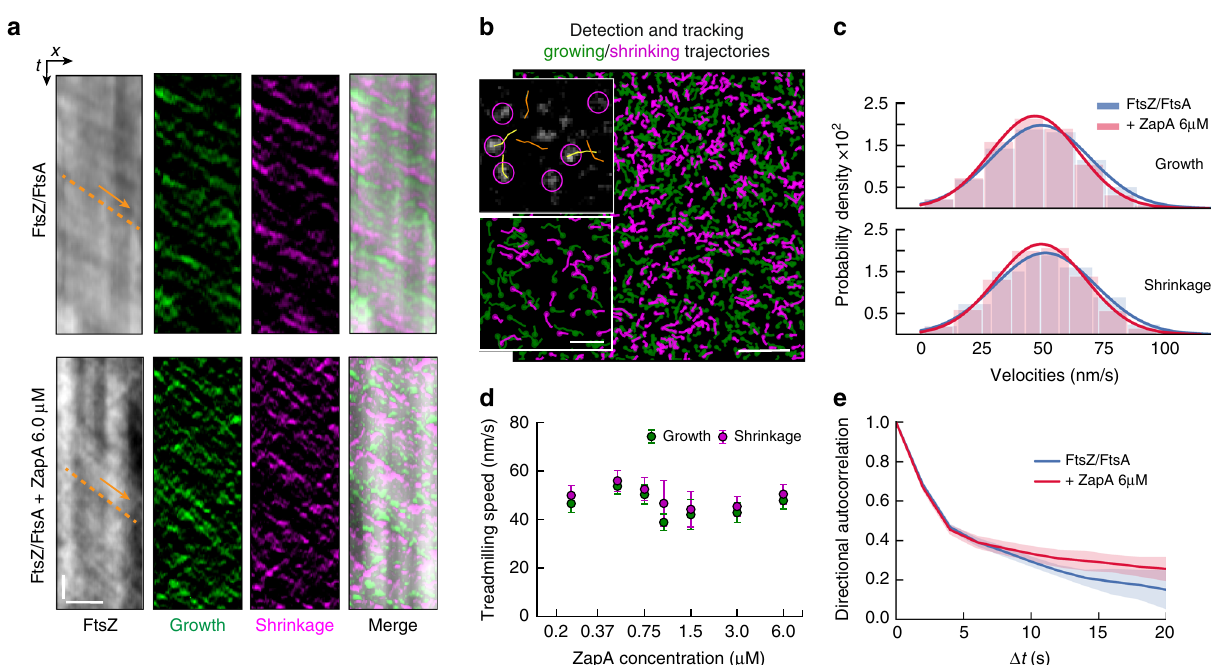
Fig. 5 ZapA does not change treadmilling speed of FtsZ fi laments. a Kymographs obtained along the orange line in Fig. 4b. Images represent the channel with the raw data, the two differential channels (growth and shrinkage trajectories) and the merged image. Arrows indicate treadmilling direction. Scale bars, t = 20 s, x = 3 μ m. b Snapshot showing an example of detection (purple circles) and tracking (yellow/orange lines) of fl uorescent spots and the respective generated growing and shrinking trajectories, respectively. First position of each trajectory is indicated with circles. Scale bars: large image, 5 μ m; small image, 2 μ m. c Velocity distribution of fi lament growth (upper panel, FtsZ/FtsA, ν + = 50.5 ± 20.1 nm/s, FtsZ/FtsA + ZapA, ν + = 47.8 ± 18.2 nm/s, n = 10) and shrinkage (lower panel, FtsZ/FtsA, ν − = 53.0 ± 20.7 nm/s, FtsZ/FtsA + ZapA, ν − = 50.4 ± 18.6 nm/s, n = 10). Both show a normal distribution without any signi fi cant difference in the mean. d Increasing concentrations of ZapA had no effect on the mean velocity of FtsZ fi laments at either end ( p > 0.05; Supplementary Table 1). e Directional autocorrelation revealed that directionality was increased in the presence of 6 μ M ZapA (red) when compared to FtsZ/FtsA (blue). Data shows the average autocorrelation curve from individual experiments (shaded bars = std, n = 10). Source data available at Figshare [https://doi.org/10.6084/m9. fi